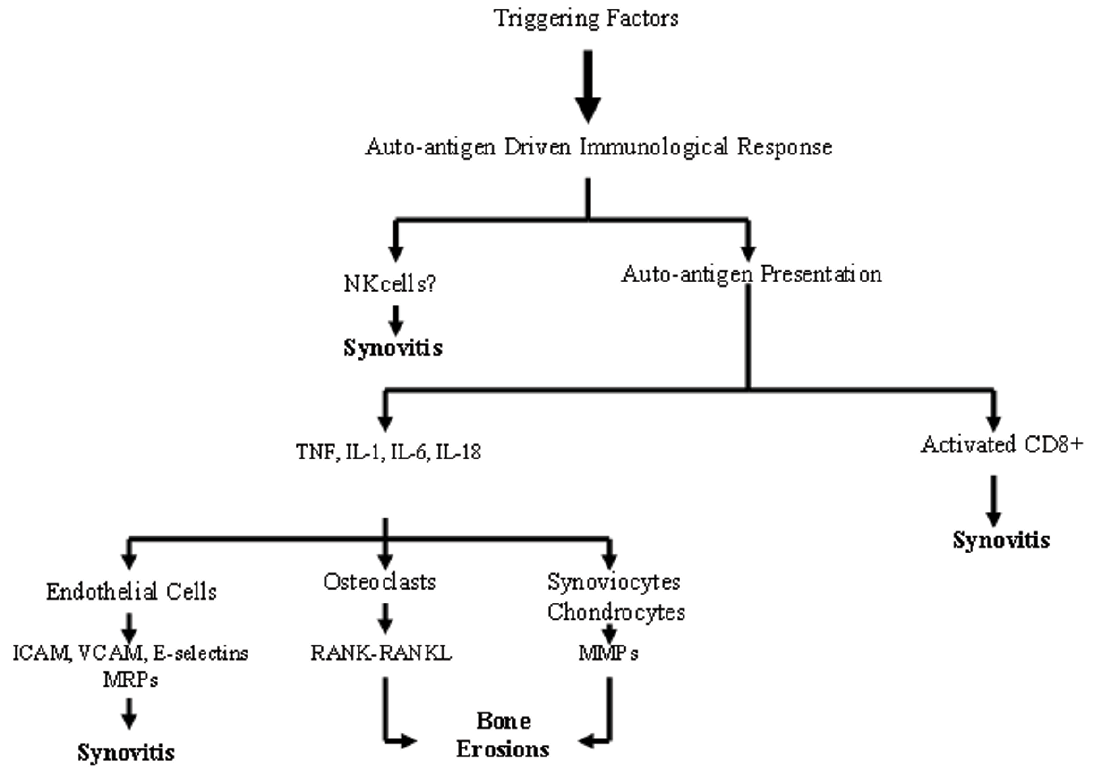
Figure 1. Current immunological concepts in the pathogenesis of Psoriatic